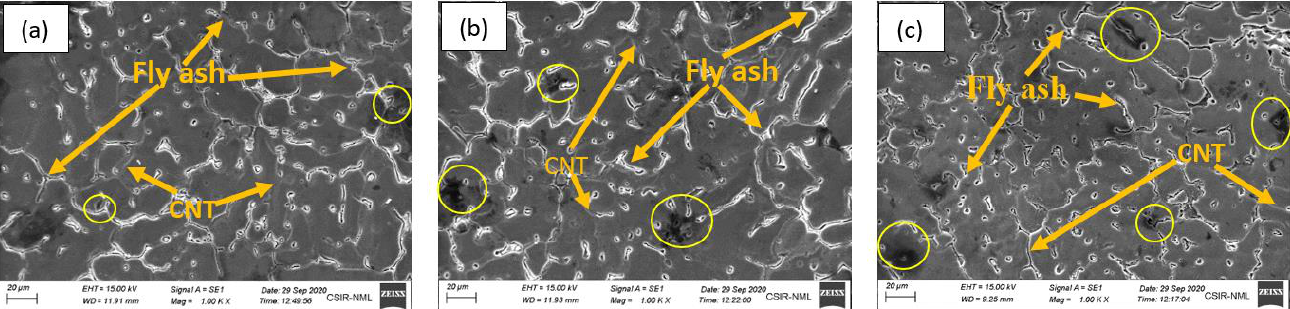
Figure 5. SEM micrographs of different specimens: ( a ) AF9C, ( b ) AF12C, and ( c ) AF15C and Porosity (Circle).